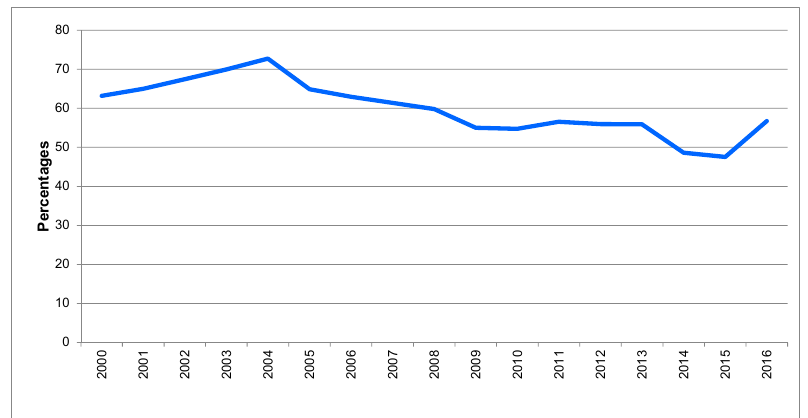
Figure 2. Products launched without any claim during 2000–2016. Source: Own elaboration based on Mintel’s GNPD data. Note: As percentage of the total number of launched products.